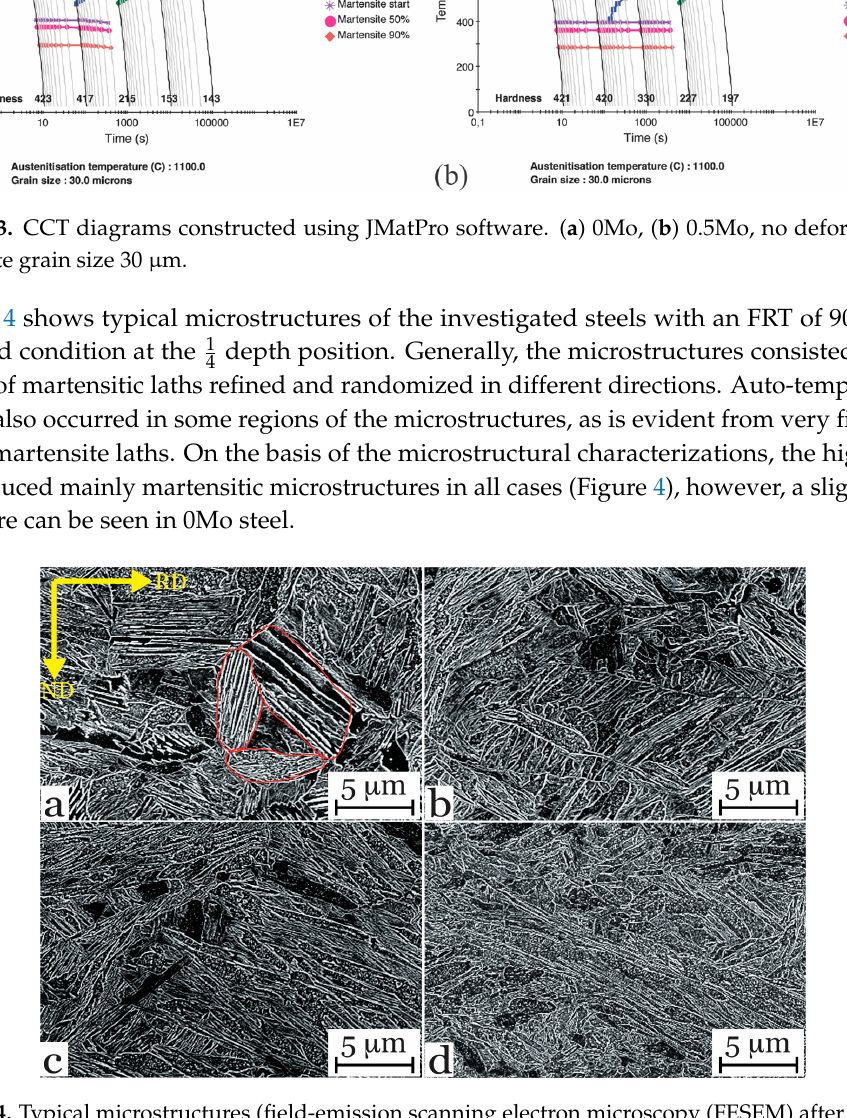
Figure 4. Typical microstructures (field-emission scanning electron microscopy (FESEM) after etching in 2% nital) of investigated steels in as-quenched condition, FRT 900 °C. ( a ) 0Mo, ( b ) 0.25Mo, ( c ) 0.5Mo, ( d ) 0.25Mo–Nb. Red lines show examples of martensite packets in the microstructure. The microstructures with an FRT of 900 °C were further characterized using EBSD. The mean effective grain and lath sizes were determined as equivalent circle diameter (ECD) values with low- angle boundary misorientations (2.5–15°), corresponding to lath size and high-angle boundary misorientations (>15°) corresponding to effective grain size. The effective grain size is used to describe the packet/block size of martensite divided by high-angle boundaries Also, the effective coarse high- angle grain sizes at the 90th percentile in the cumulative grain area distribution ( d 90%) were determined. The results, presented in Figure 5a, revealed no great differences in the various grain sizes of the transformed microstructures. Mo and Mo–Nb microalloying led to a small decrease in the mean effective grain and lath sizes, presumably because of the more pancaked austenite structures, corroborating the results presented in Table 2. However, no significant differences between d 90% grain sizes were observed, although the 0.25Mo–Nb steel shows a somewhat higher d 90% value. Furthermore, on the basis of the EBSD data, ECD effective high-angle grain sizes at different percentiles in the cumulative grain area distribution of the investigated steels after direct quenching from an FRT of 900 °C are given in Figure 6. Differences can only be seen in the 80th and 90th percentile grain diameters ( d 80% and d 90%), indicating that there are only minor differences in the grain size distributions. Also, grain misorientation angle distributions were determined using the EBSD data, and the results are presented in Figure 5b. Misorientation peaks at ~7.5° (sub-block boundaries), 16°, 52.5°, and 59° (packet or/and block boundaries) were detected, and they are a result of the different variants of the Kurdjumov–Sachs orientation relationship. Clear peaks at ~7.5° and ~59° are typical peaks for martensite or lower bainite microstructures [12,13]. On the basis of the misorientation distributions, no clear differences between the studied steels are apparent, which further supports the conclusion that all the investigated steels comprised mainly martensite in the direct-quenched condition when an FRT of 900 °C was used, as was also observed in other microstructural investigations. The defined low-angle and high-angle boundaries of investigated steels with an FRT of 900 °C can be seen from Figure 7. The lath-type structure with high density of low-angle boundaries (red lines) are clearly visible in Figure 7. Also slightly more elongated grain structure of 0.25Mo-Nb steel can be seen from Figure 7d.